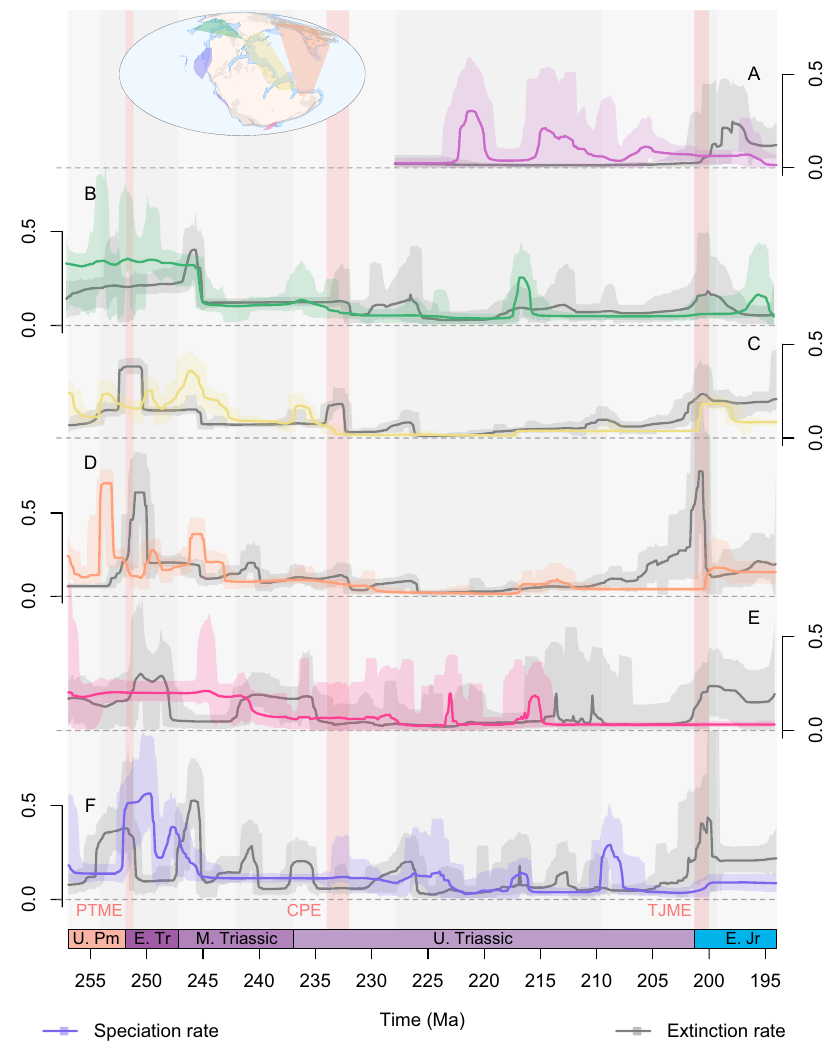
Fig. 5 Probabilistic speciation and extinction rates and their 95% highest posterior densities through the Late Permian to Early Jurassic (259.5 – 192.9 Ma). Extinction and speciation rates differ markedly between sampling regions through our study interval, even during globally pervasive biological upheavals like the end-Permian mass extinction (PTME), Carnian Pluvial Episode (CPE), or end-Triassic mass extinction (TJME). Deconvolving the diversi fi cation rates in Fig. 3 into the component speciation and extinction processes is additionally important to capture pulses of cryptic turnover where net diversi fi cation and so the change in diversity is only small. Displayed results are derived from PyRate applied to datasets standardised by minimum spanning tree length, meaning that the results are unbiased by heterogenous sampling through time and across space. A South Panthalassic. B Boreal. C West Circumtethys. D East Circumtethys. E Tangaroan. F North Panthalassic. Source data are provided as a Source Data fi